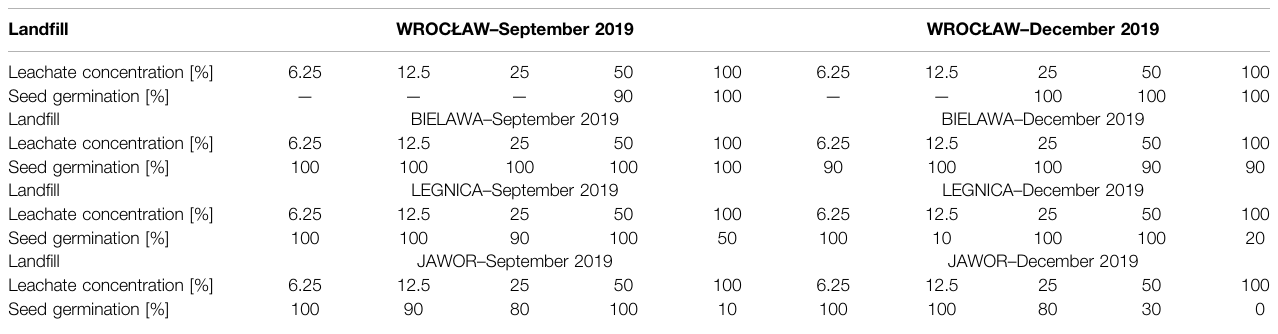
TABLE 5 | Effect of increasing land fi ll leachate concentrations on seed germination of Sinapis alba L. Land fi